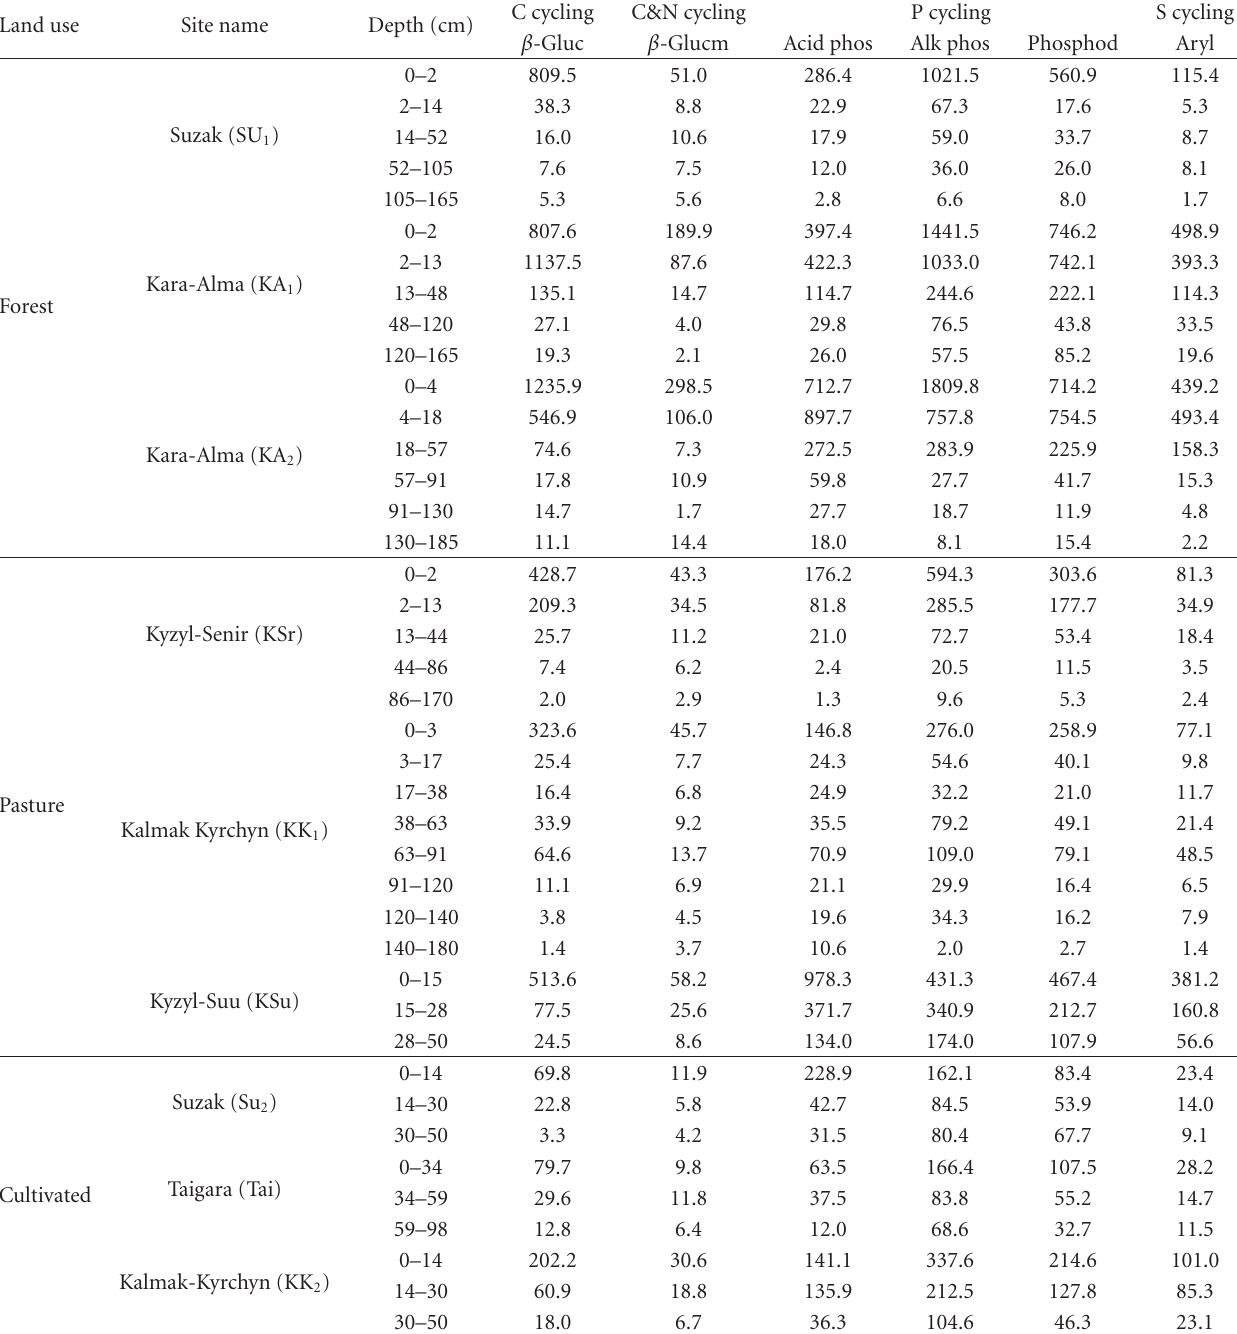
Table 4: Enzyme activities (mgPNkg − 1 soilh − 1 ) for the Kukart watershed sites of Kyrgyzstan a . Land use